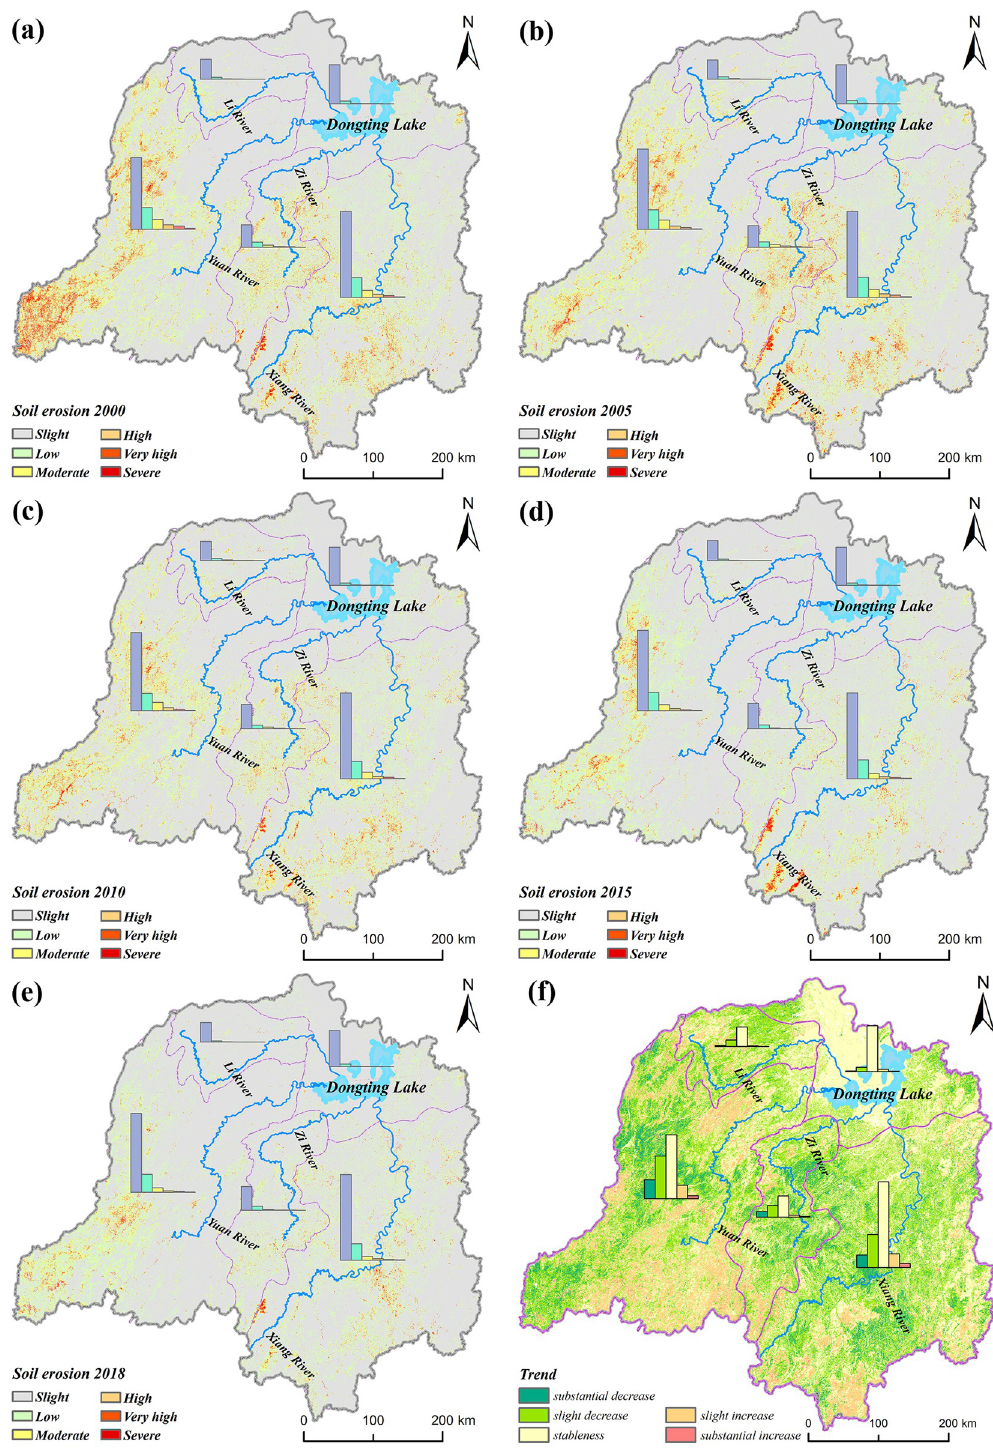
Fig 3. Spatial distribution of soil erosion in the study area from 2000 to 2018. (a) 2000, (b) 2005, (c) 2010, (d) 2015, and (e) 2018. (f) Trends of soil erosion in the study area from 2000 to 2018. The image was created using ARCGIS 10.2 software with the authors’